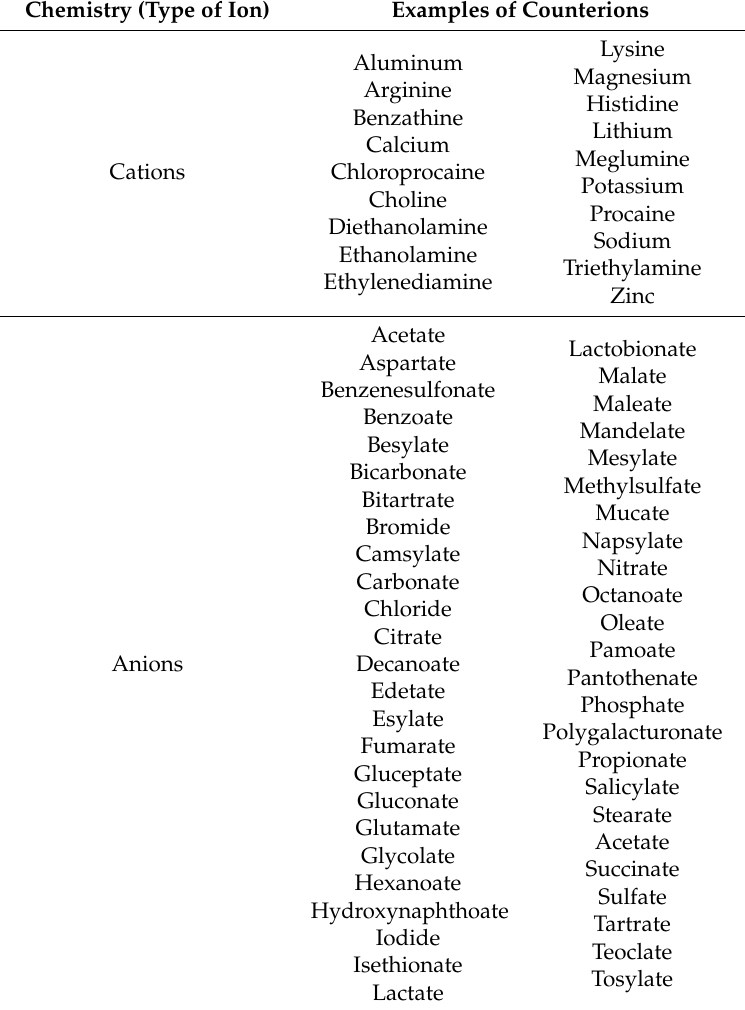
Table 1. List of currently available counterions for salt formation